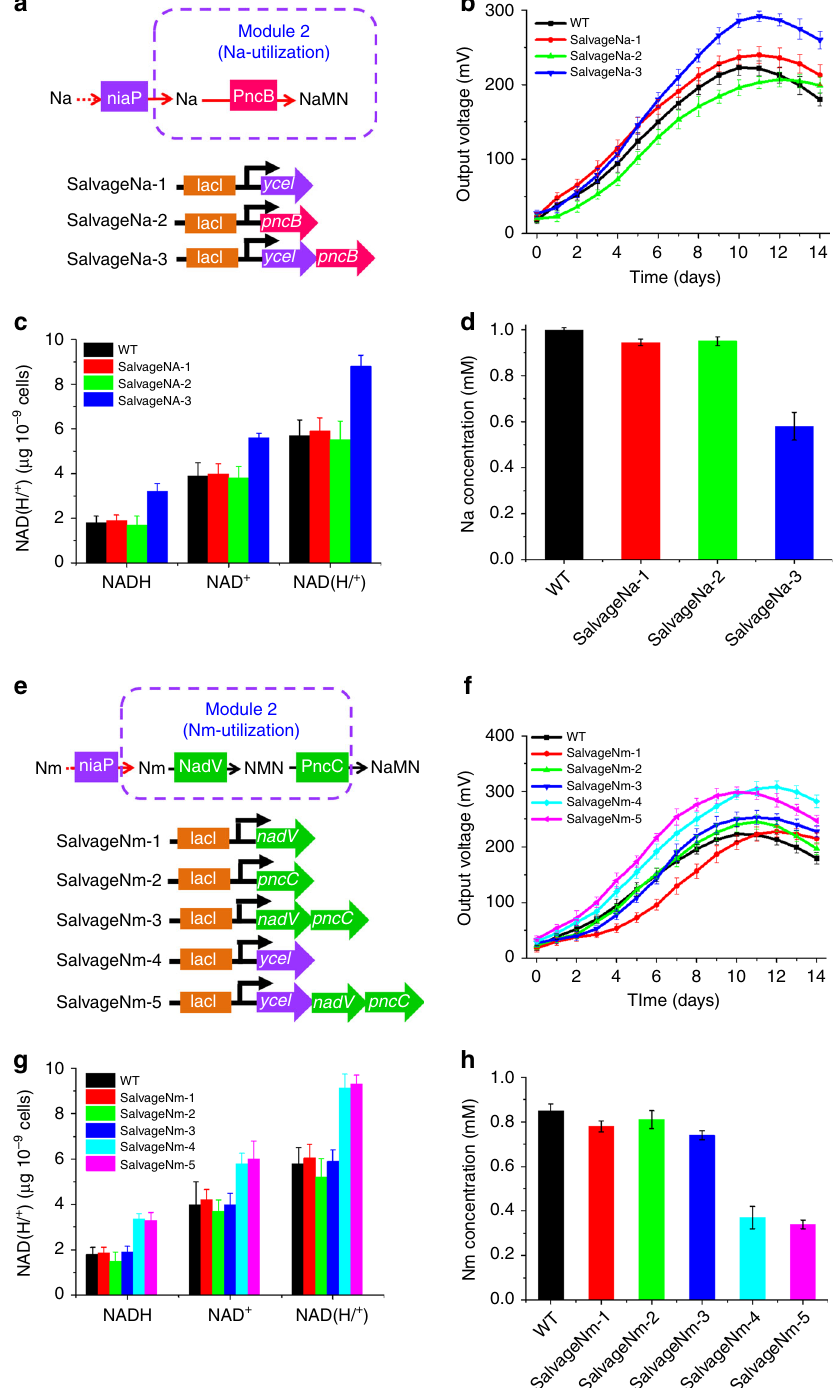
Fig. 3 Optimization of the salvage biosynthesis pathway (Module 2) to facilitate nicotinic acid (Na) and nicotinamide (Nm) utilization. a A depiction of the engineered Na salvage biosynthesis pathway for NAD + biosynthesis (Module 2). Plasmids that included the assemblage of genes ( pncB and ycel ) in the Na-utilization pathway of Module 2. b Voltage output in MFCs of the above S. oneidensis recombinant strains supplemented with 1 mM Na. c Quantitative measurements of the intracellular NAD + , NADH, and total NAD(H/ + ) levels of these strains under anaerobic cultures. d Na concentrations of the recombinant strains in the MFC anolytes. e Optimization of the salvage biosynthesis pathway (Module 2) of the Nm-utilization pathway. A depiction of the engineered Nm salvage biosynthesis pathway (Module 2). Plasmids that included the assemblage of genes ( nadV , pncC , and ycel ) in the Nm-utilization pathway of Module 2. f Voltage output in MFCs of the above S. oneidensis recombinant strains supplemented with 1 mM Nm. g Quantitative measurements of the intracellular NAD + , NADH, and total NAD(H/ + ) levels of these strains under anaerobic cultures. h Nm concentrations of the recombinant strains in the MFCs